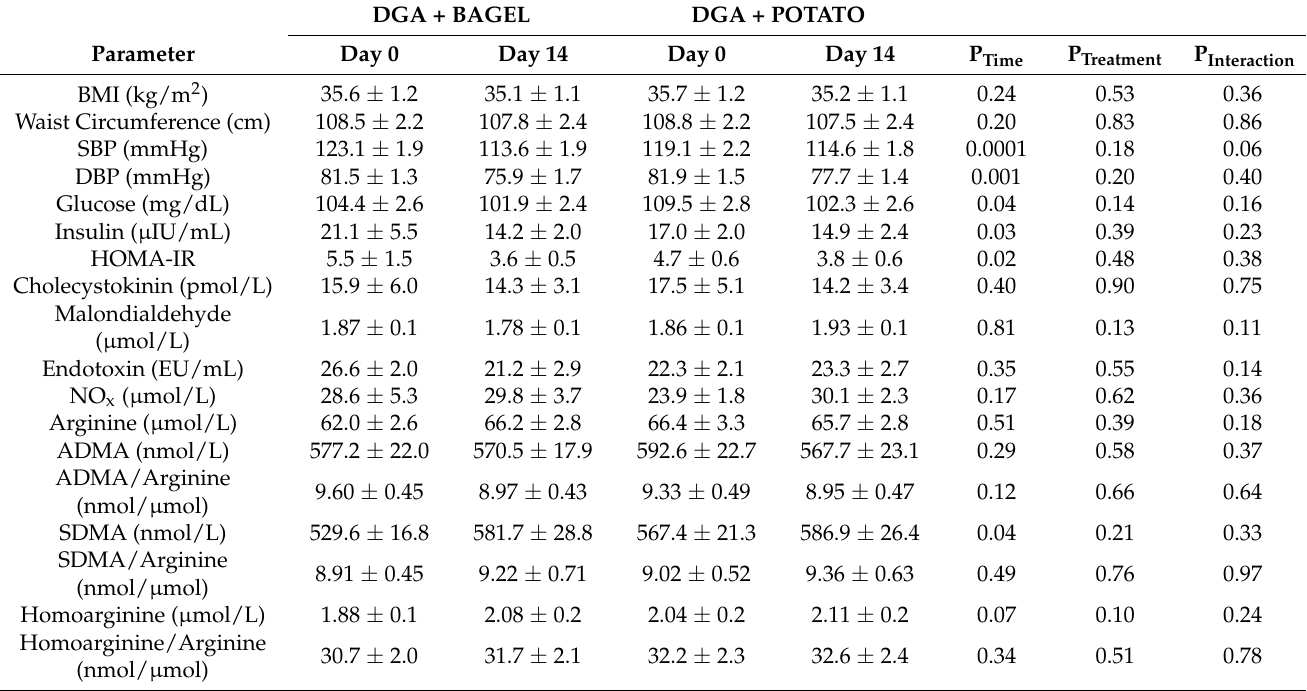
Table 3. Clinical and biochemical parameters of MetS persons who consumed a DGA -based dietary pattern containing a daily serving of a bagel (DGA + BAGEL) or potato (DGA + POTATO) for 2-week 1,2 . DGA + BAGEL DGA +